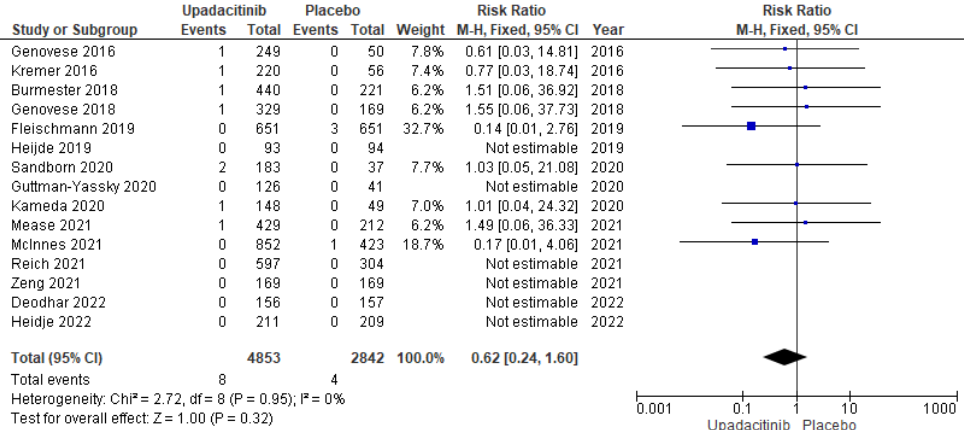
Figure 4. Forest plot of the comparison: upadacitinib vs. placebo. Outcome: major adverse cardio-